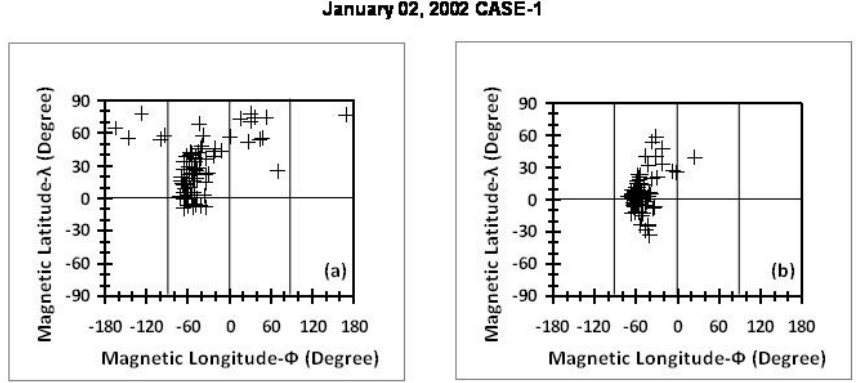
Fig. 8. Scatter plots of magnetic latitude versus magnetic longitude (a) within Bursts 1 and 2, and (b) in the ambient magnetosheath surrounding Burst 1 and Burst 2 for 2 January